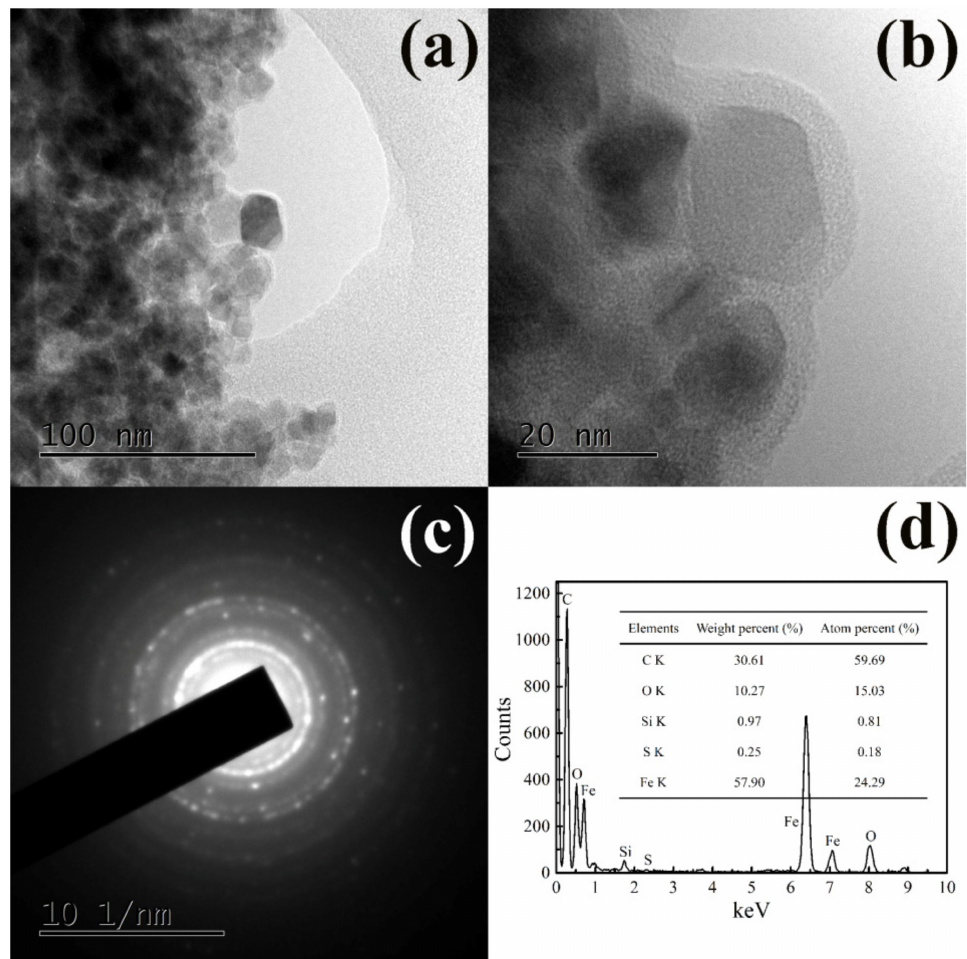
Figure 3. The ( a ) and ( b ) transmission electron microscopy (TEM), and ( c ) selected area electron diffraction (SAED) images, and ( d ) energy dispersive X-ray (EDX) ( spectrum along with element analysis data for the wool keratin modified Fe 3 O 4